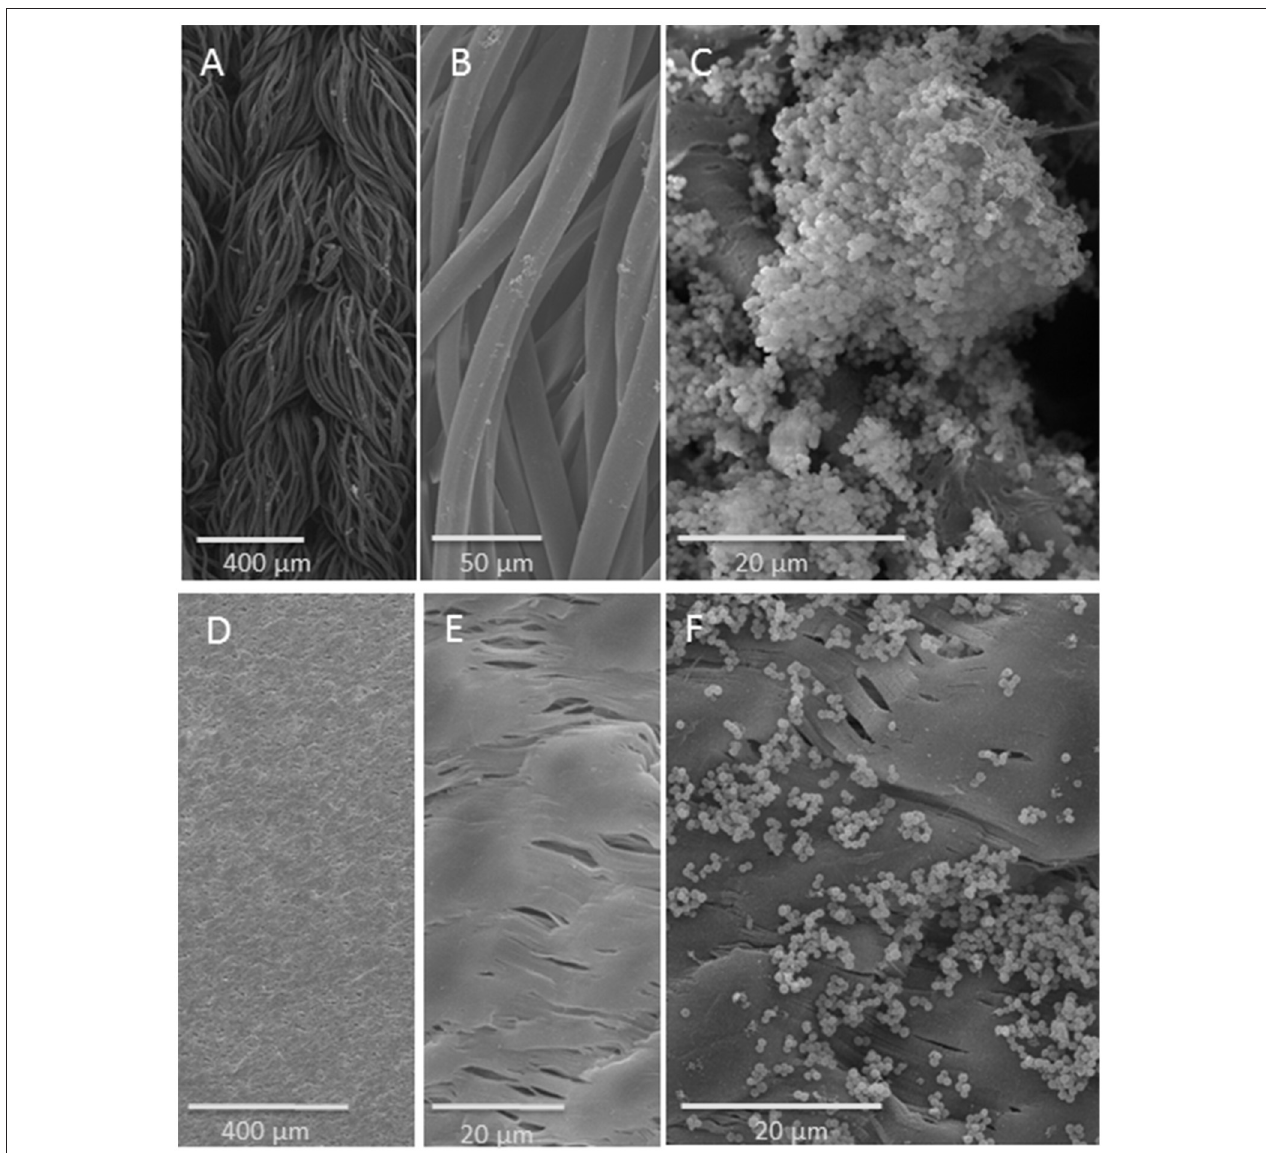
FIGURE 2 | SEM analysis of vascular graft material: upper row: on Dacron fiber, lower row: on PTFE surface: (A) knitted structure; (B) fibers; (C) S. aureus strain SH1000 biofilm on Dacron fiber. (D , E) PTFE surface in different magnifications; (F) S. aureus strain SH1000 on